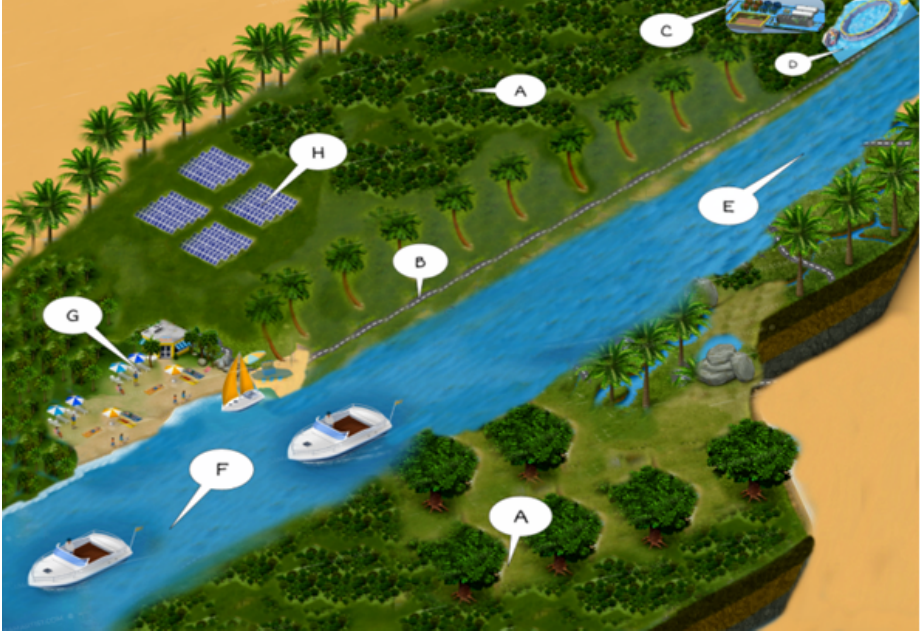
Figure 1: 3D Model of the proposed Malir Expressway Urban Forest and Recreational Zone. Here the recreational zones are detailed, which includes water recycling and usage in promoting greenery as well as entertainment (activities as well as food items), to be established on the lower banks of Malir River in